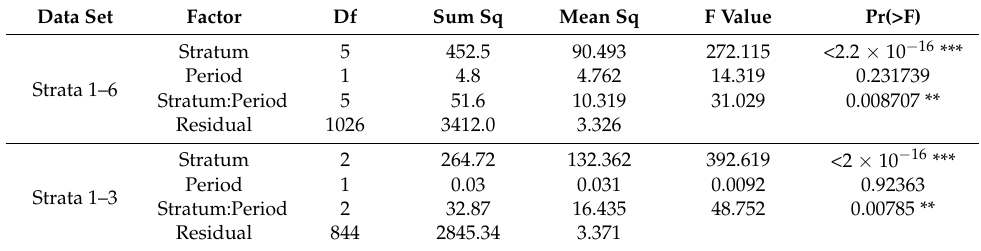
Table A1. Two-way ANOVA with interaction. Variable: Consumption per household.